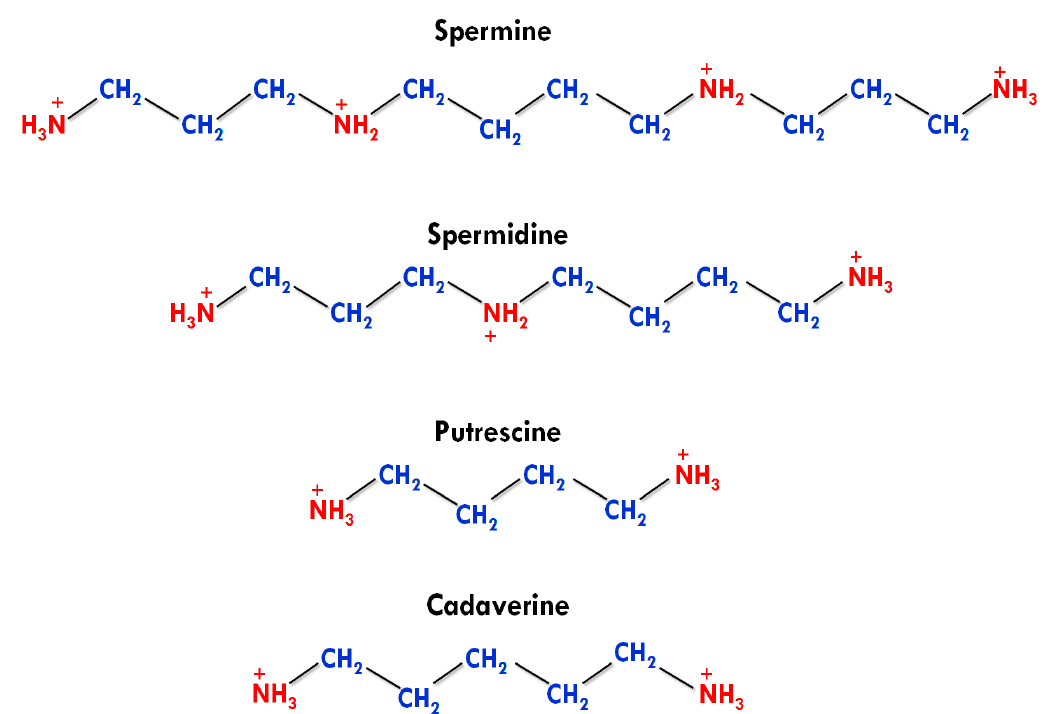
Figure 1. Structures of different polyamines [38].